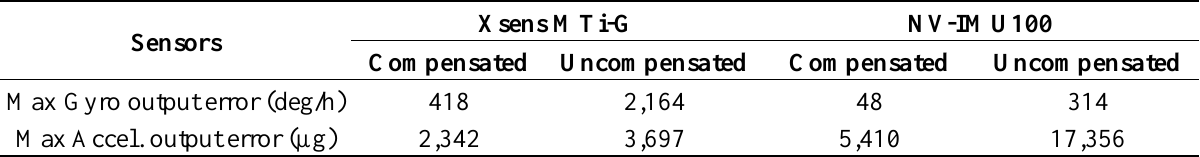
Table 13. RMS of IMU output errors with and without thermal